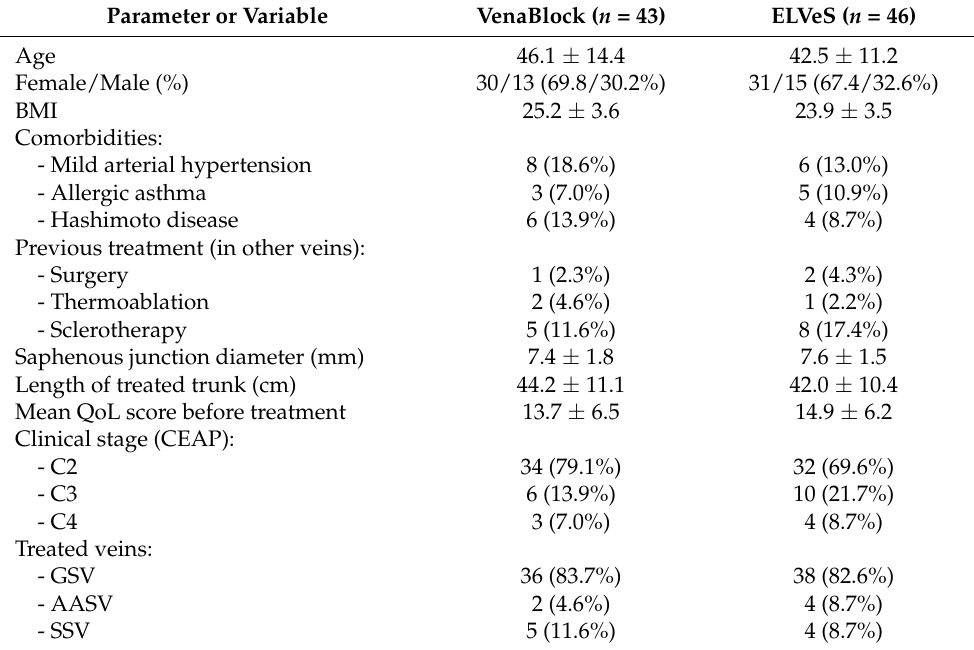
Table 1. Baseline features of the two treated groups. Values in table represent mean ± standard deviation, or number (percent) in the group,